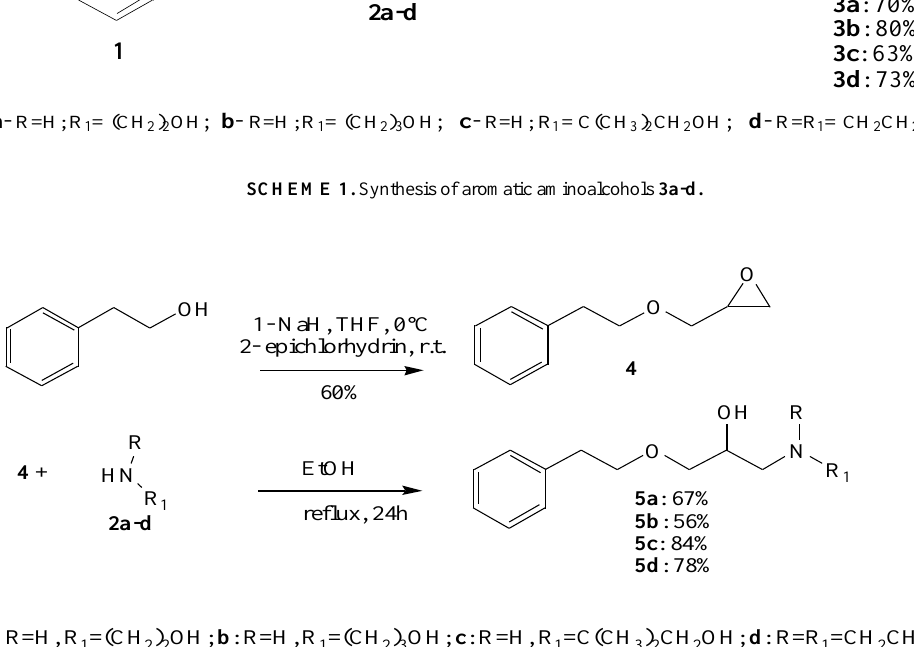
SCHEME 2 . Synthesis of aromatic aminoalcohols 5a-d from phenethyl